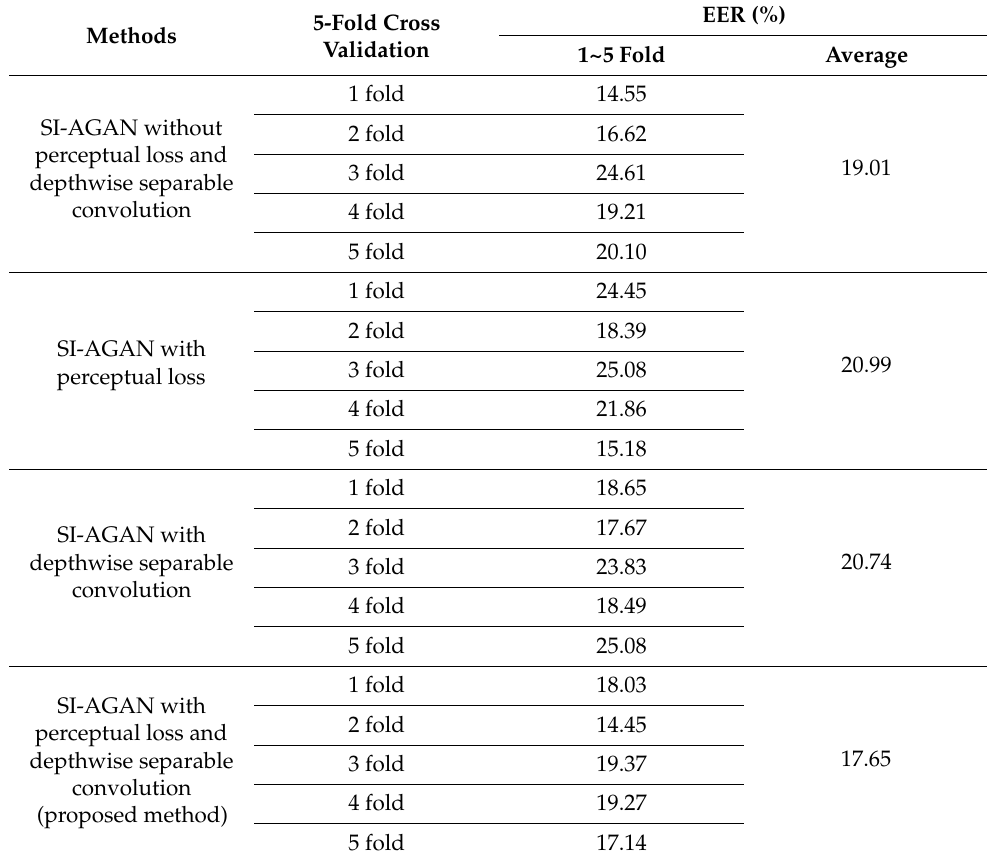
Table 9. Comparison of the gender recognition accuracies of SI-AGAN with or without perceptual loss and depthwise separable